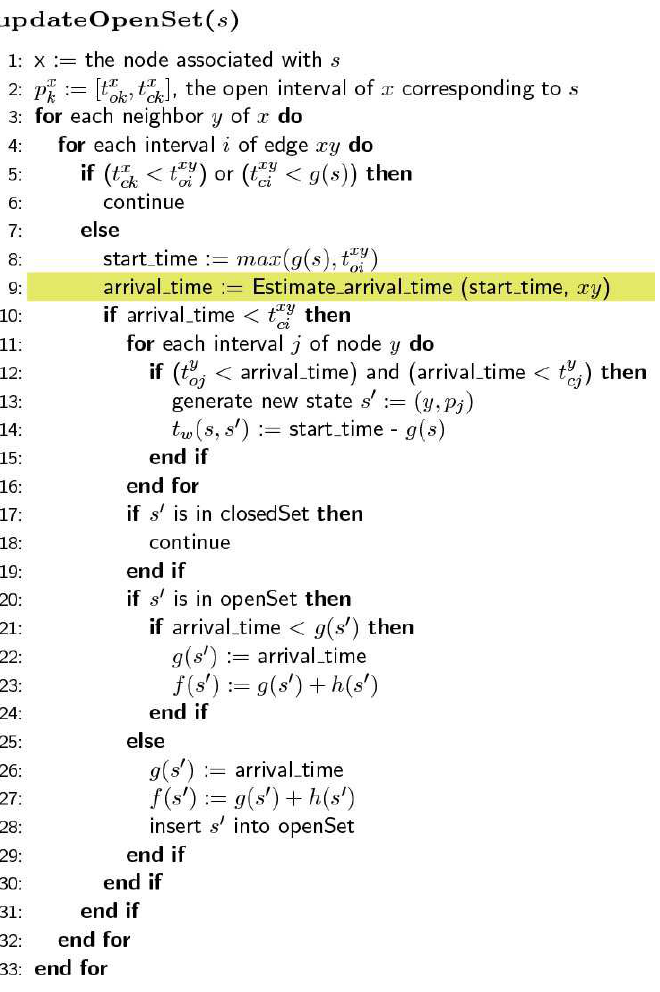
Figure 3. Structure of the MOAAstar–TI (Moving Obstacle Avoiding A* using Traffic Information) algorithm.